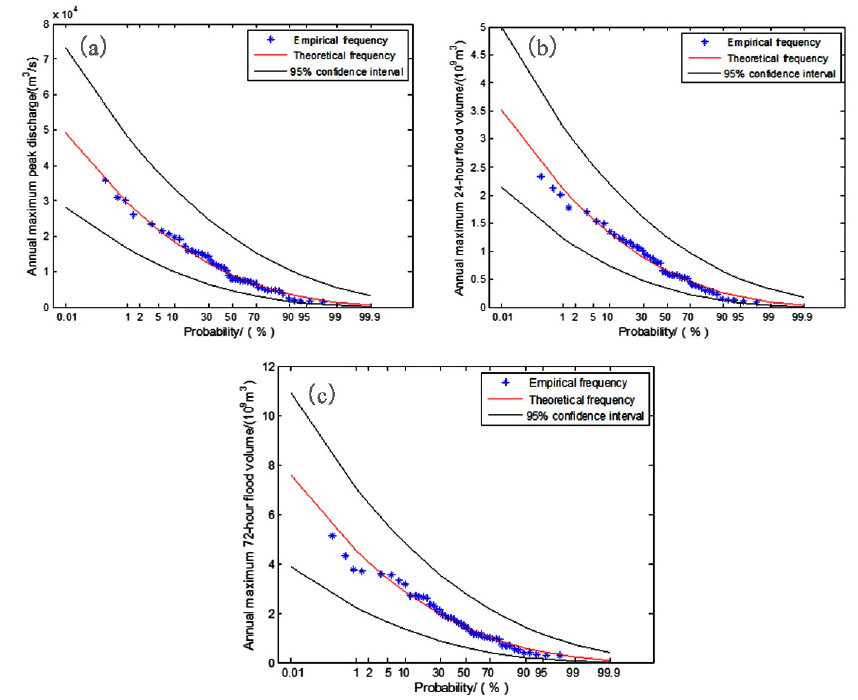
Figure 5. 95% confidence intervals computed using the bootstrap method for flood characteristic series. ( a ) 95% confidence intervals of the annual maximum peak discharge; ( b ) 95% confidence intervals of the annual maximum 24-h flood volume; and ( c ) 95% confidence intervals of the annual maximum 72-h flood volume.